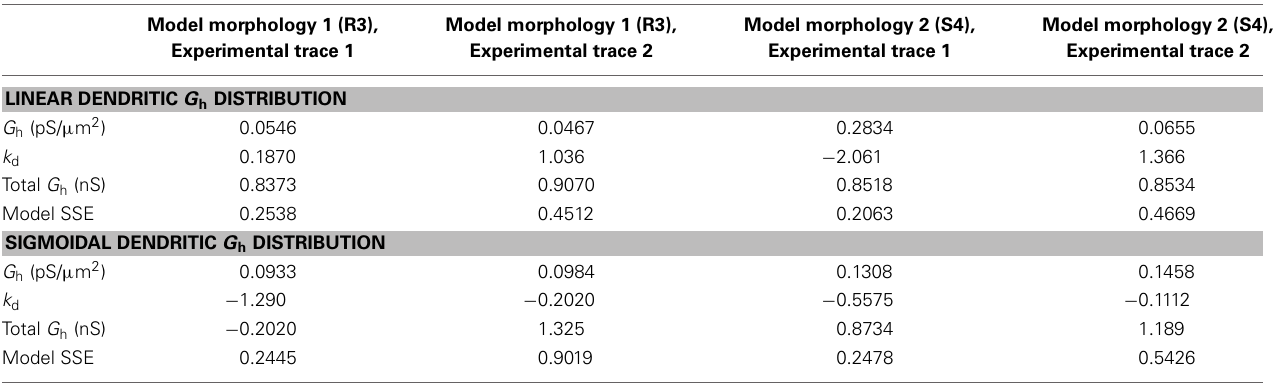
Table 3 | Refitted G h and k d values in the models with both linear and sigmoidal dendritic G h distributions. Model morphology 1 (R3),